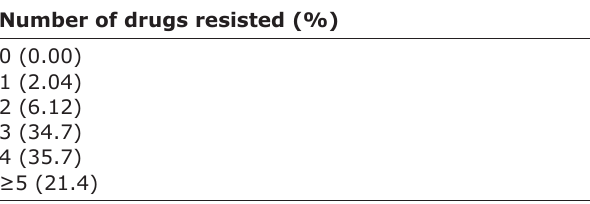
Table-4: Multidrug resistance profile of MRSA isolated from hunting dogs in Maiduguri metropolitan. Number of drugs resisted (%)